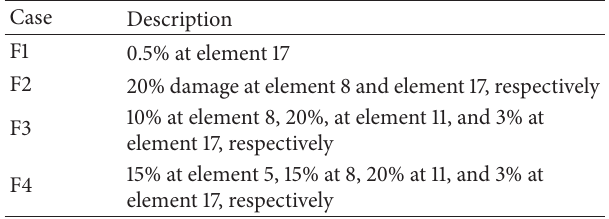
Table 5: Various damage conditions of the